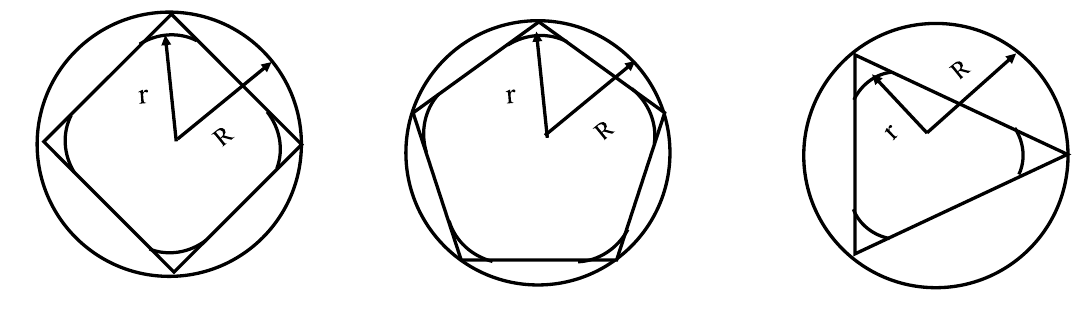
Figure 12: Bluntness for different shapes of hole